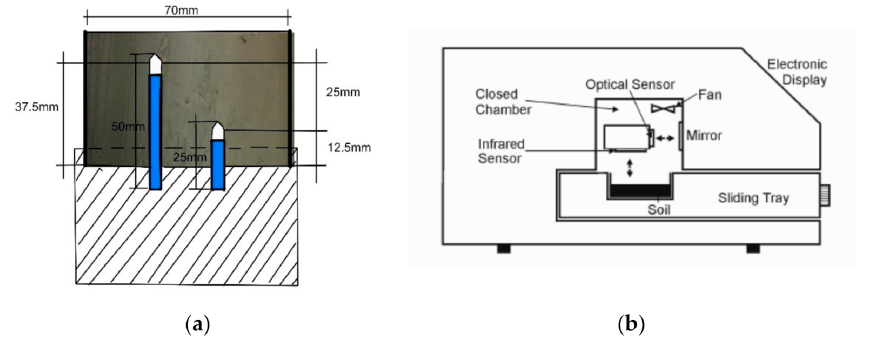
Figure 1. Geometry and cross section of ( a ) the Hyprop device edited from the User Manual Hyprop, 2012 [23], and ( b ) The Decagon dew point potentiometer WP4C ® Cross Section